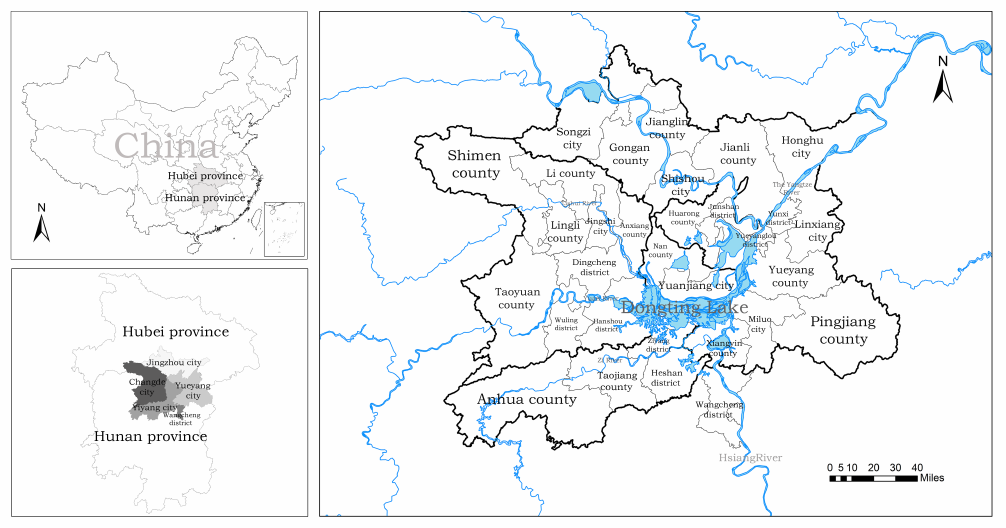
Figure 2. Map of study area in China.